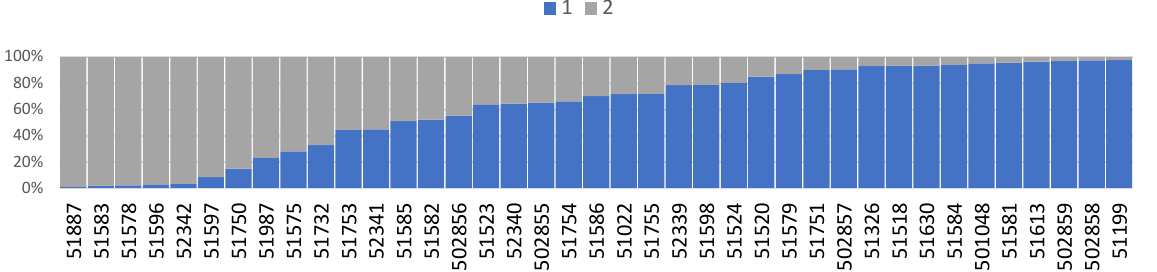
Figure 3. Bar graphs showing the population structure of 39 accessions of Avena strigosa L. based on the resistance to five isolates of Puccinia coronata f. sp. avenae as assessed using STRUCTURE. Each population is represented by a different color.